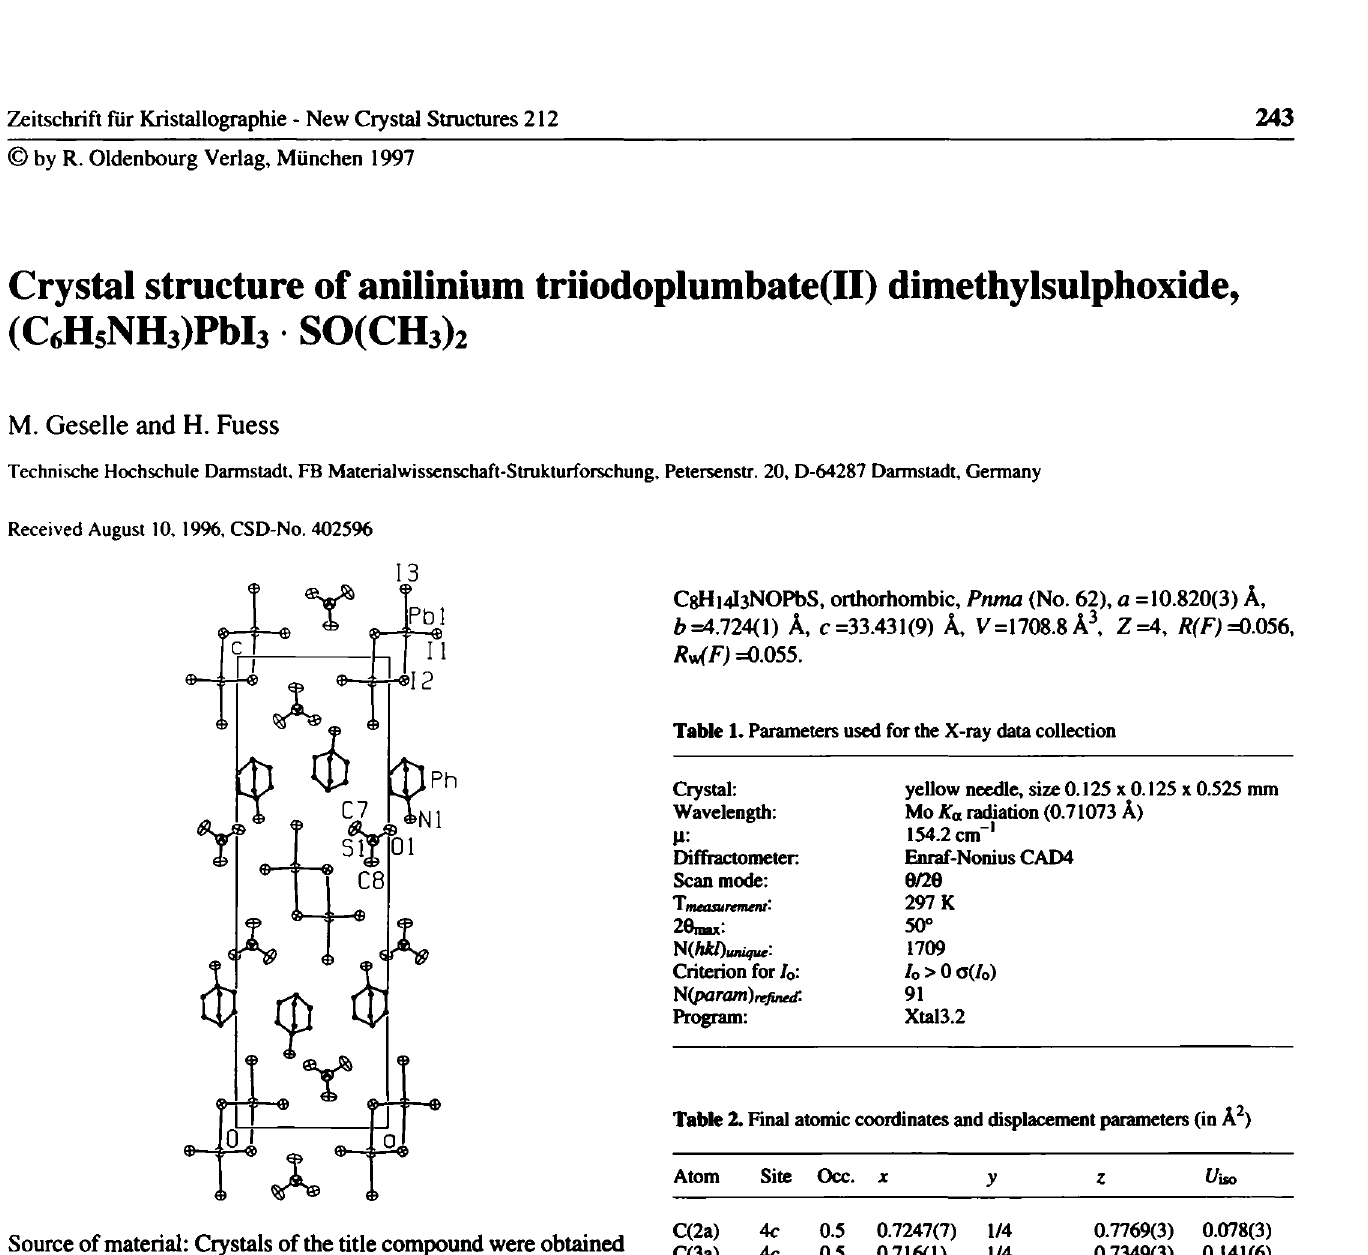
Table 2. Final atomic coordinates and displacement parameters (in Â 2